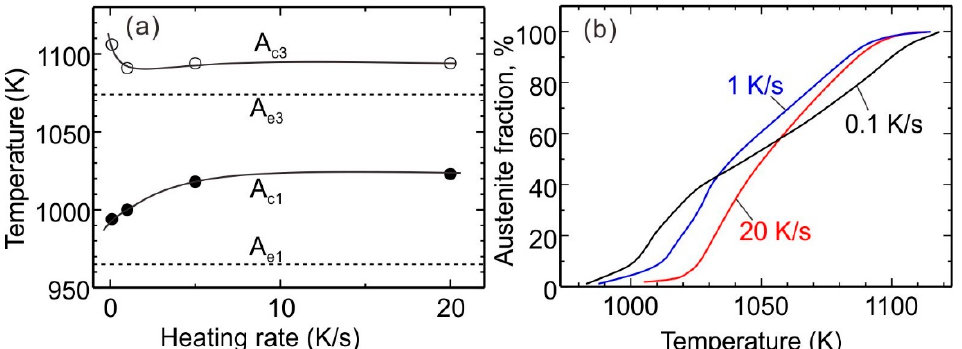
Figure 1. ( a ) The measured A c1 and A c3 temperatures as a function of heating rate, ( b ) γ reversion kinetics at different heating rates.